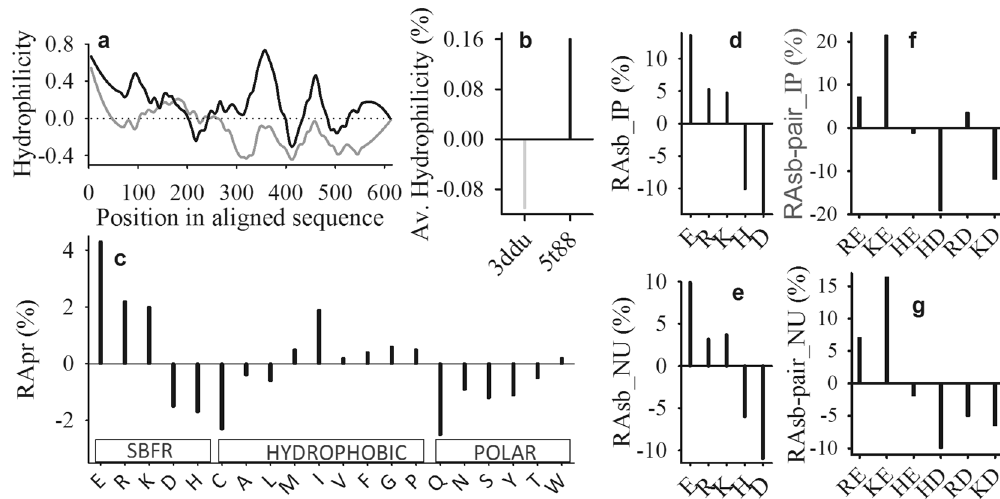
Figure 1. PfP has higher hydrophilicity due to the higher abundance of salt-bridge forming residues (SBFR). Hydrophilicity profiles ( a ) and grand average hydrophilicity ( b ) of PfP (black) and HuP (grey). Normalized relative abundance (RApr in %) of salt-bridge forming residues (charged), hydrophobic, and polar classes of amino acids ( c ) of the sequence of PfP in reference to HuP. Normalized relative abundance (in %) of salt-bridge forming residues for isolated pair ( d ) and network unit ( e ) types of salt-bridges of PfP in reference to HuP. The normalized relative abundance of pair-types of salt-bridge for isolated-pair (f) and network unit ( g ) of PfP in reference to HuP.